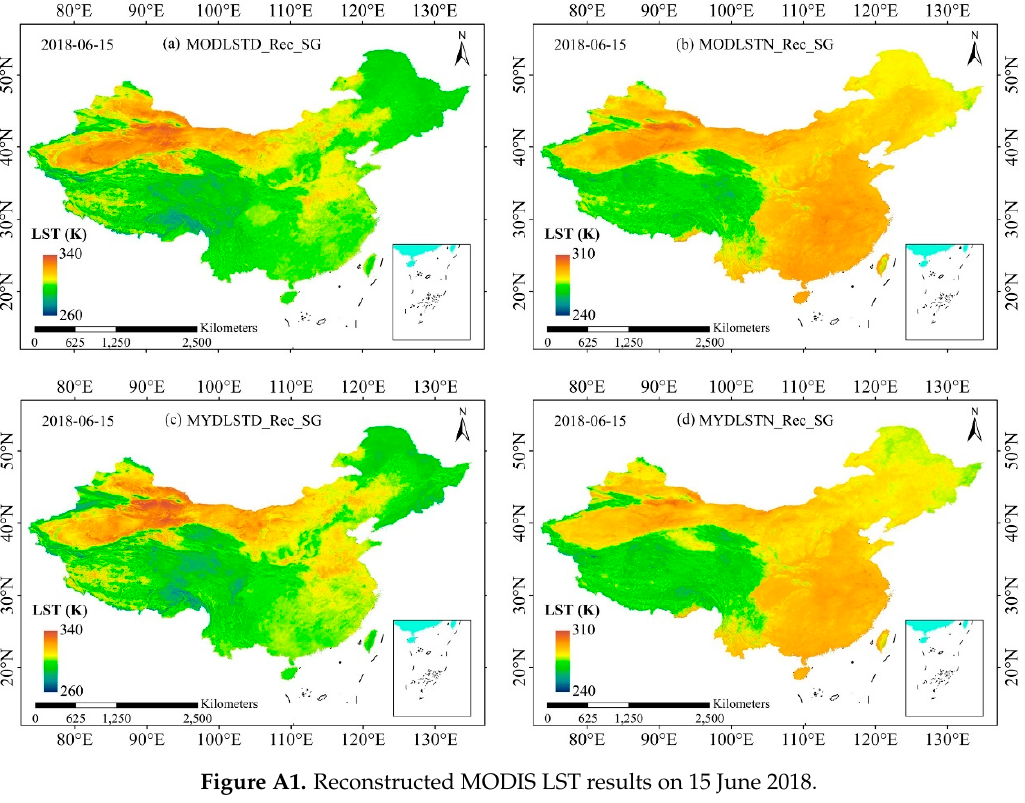
Figure A1. Reconstructed MODIS LST results on 15 June 2018.